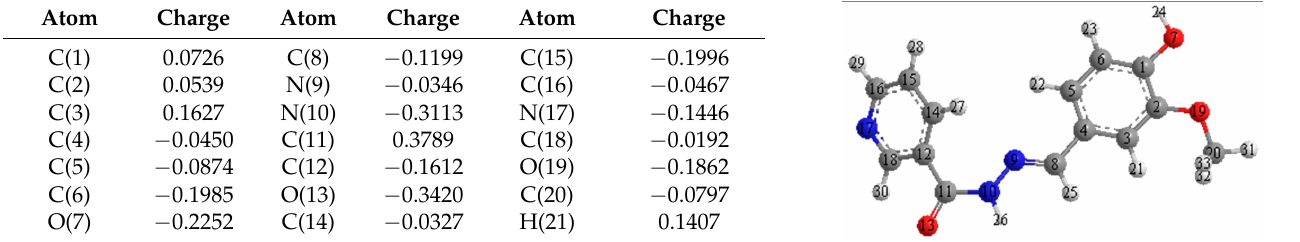
Figure 11. The optimized structure ( a ), HOMO ( b ) and LUMO ( c ) of the tested corrosion inhibitor.